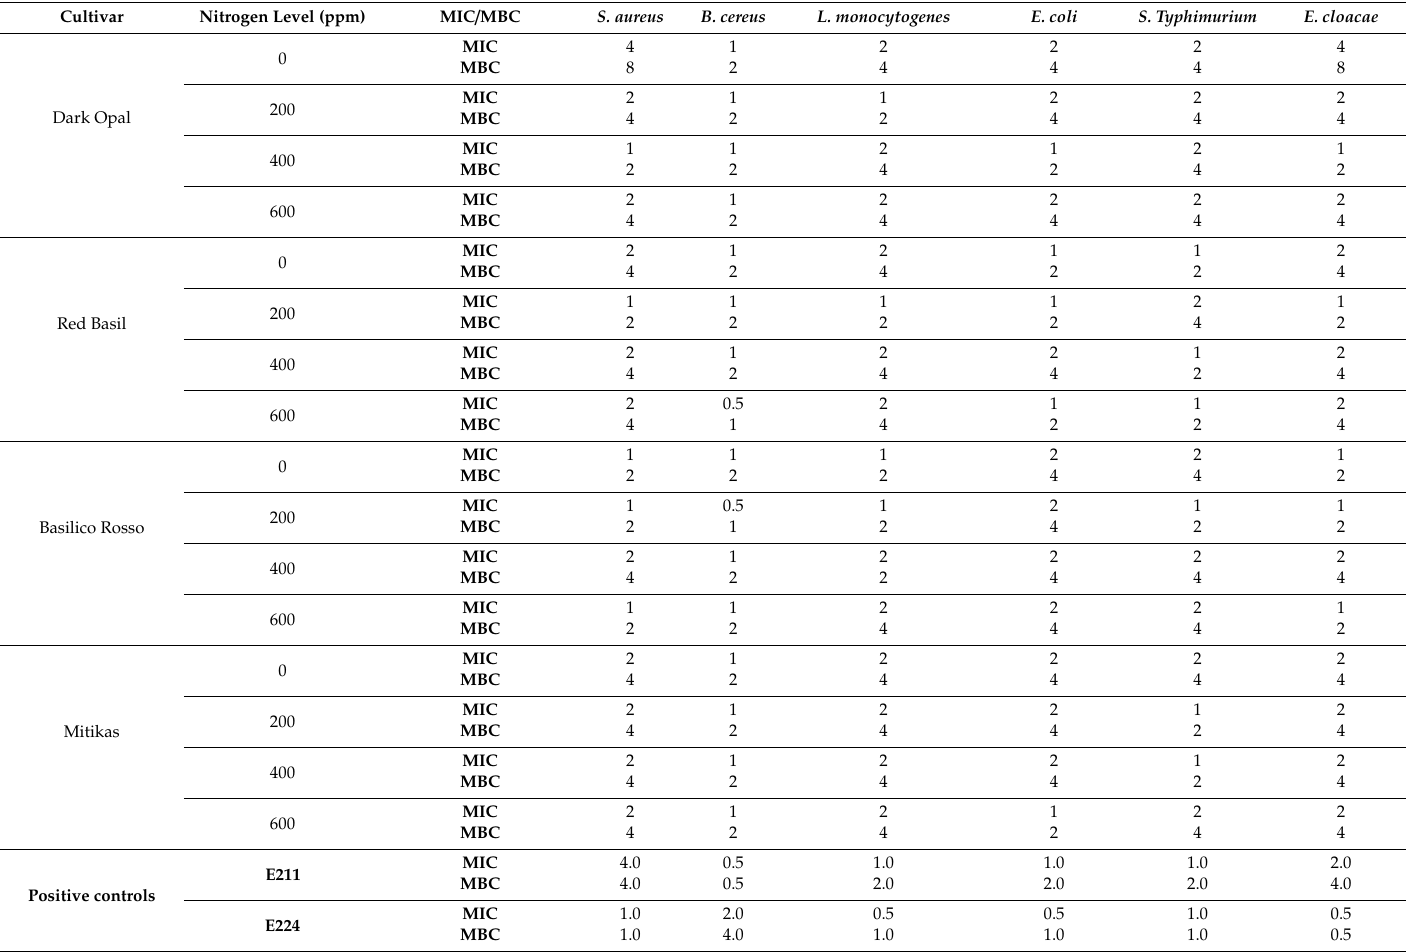
Table 7. Antibacterial activity (minimal inhibition concentration (MIC) and minimal bactericidal concentration (MBC) mg / mL) of the leaves’ hydroethanolic extracts of the studied basil genotypes in relation to nitrogen